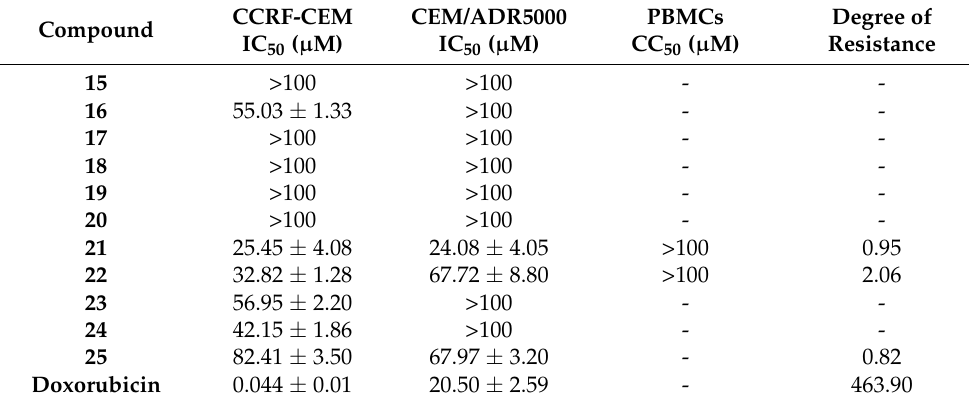
Table 2. Cytotoxicity of compounds 15 – 25 towards drug-sensitive acute lymphocytic leukemia cells (CCRF-CEM), multidrug-resistant leukemia sub-cell line (CEM/ADR5000), and healthy peripheral blood mononuclear cells (PBMCs) using the resazurin reduction assay. All values are shown as mean ± standard deviation (SD) of three independent experiments. The degree of resistance was calculated by dividing the IC 50 value of resistant by that of sensitive cells. CCRF-CEM Compound IC 50 ( µ M)